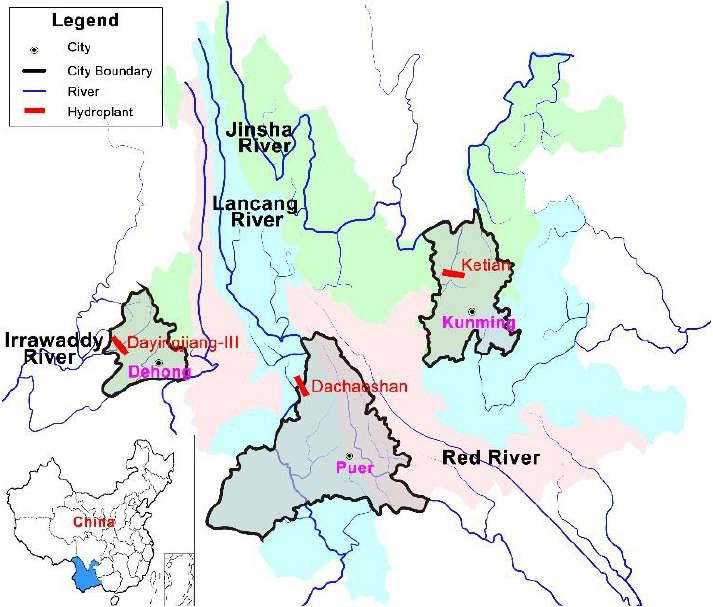
Figure 4. Map of typical basins, prefectures and large-medium hydropower (LHP) plants in Yunnan